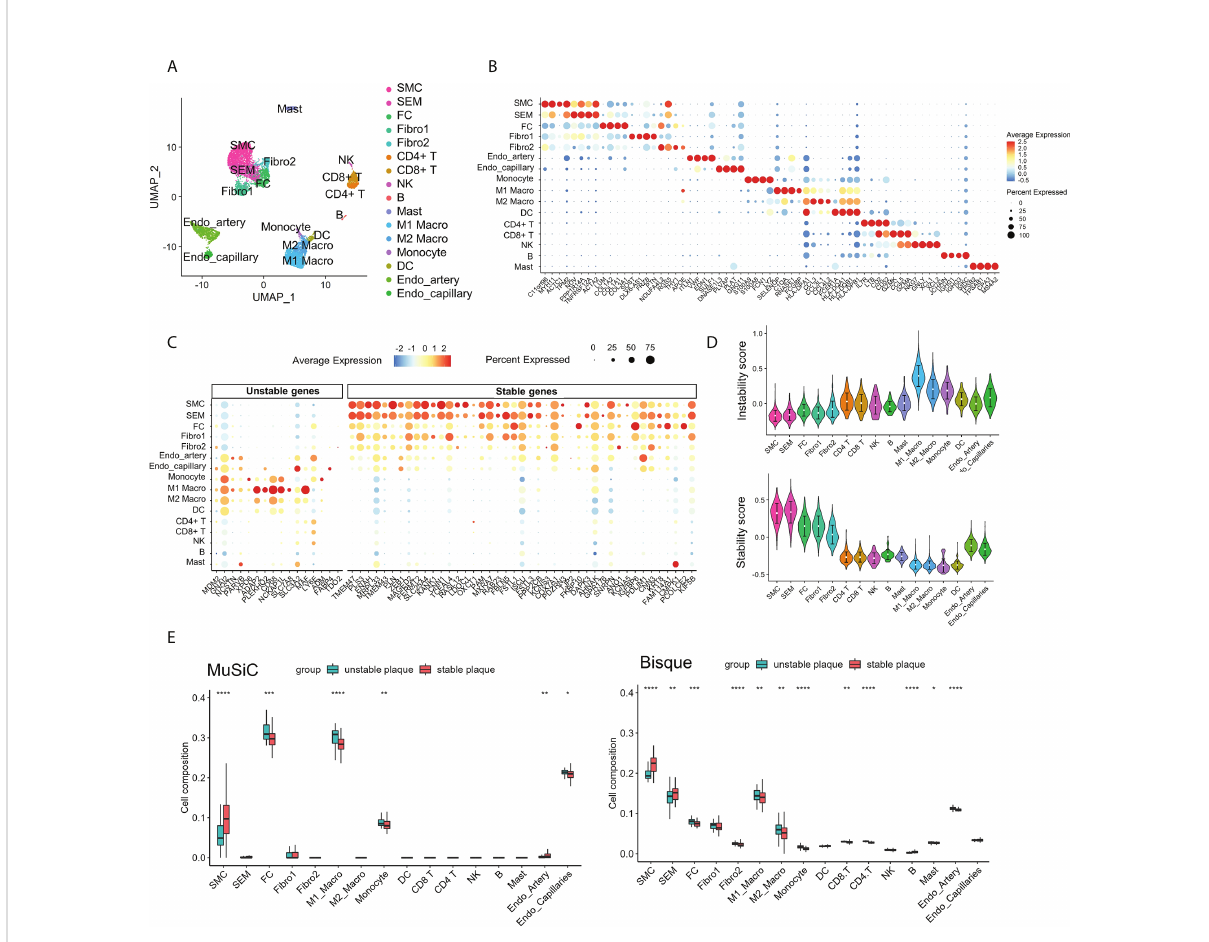
FIGURE 4 Contribution of M1 macrophages to atherosclerotic plaque instability. (A) UMAP projection showing the single-cell atlas of carotid atherosclerotic plaques. (B) Dot plot displaying the fractions of expressing cells (dot size) and mean expression level in expressing cells (dot color) of marker genes (rows) across clusters. (C) Dot plot showing the expression of DEGs in different clusters of carotid atherosclerotic plaques. (D) Violin plots showing the instability score (upper) and stability score (lower) in atherosclerotic plaque clusters. (E) Immune cell in fi ltration in unstable and stable plaques estimated by Music and BisqueRNA. * p < 0.05; ** p < 0.01; *** p < 0.001; **** p <